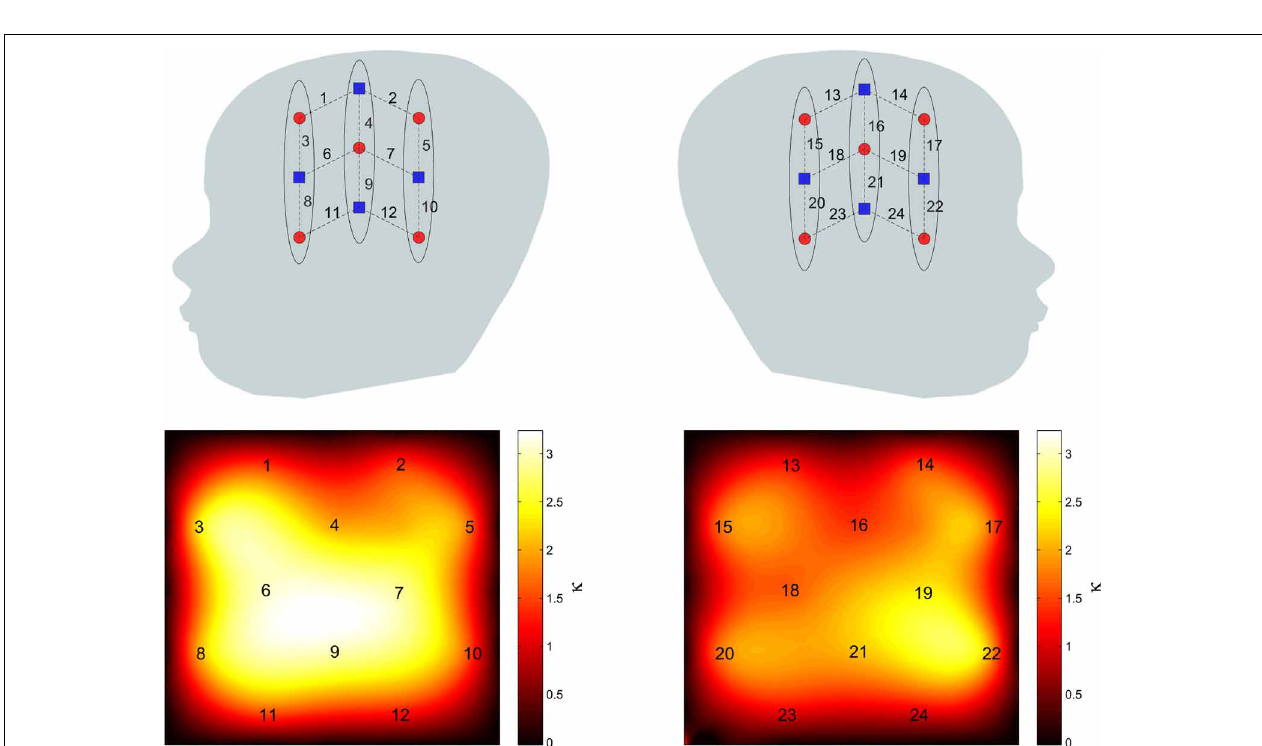
FIGURE 3 | Filtered HbO 2 signal recorded from two channels with high degree of connection (A) and the distribution of the phases for each channel [(B) for channel 7 and (C) for